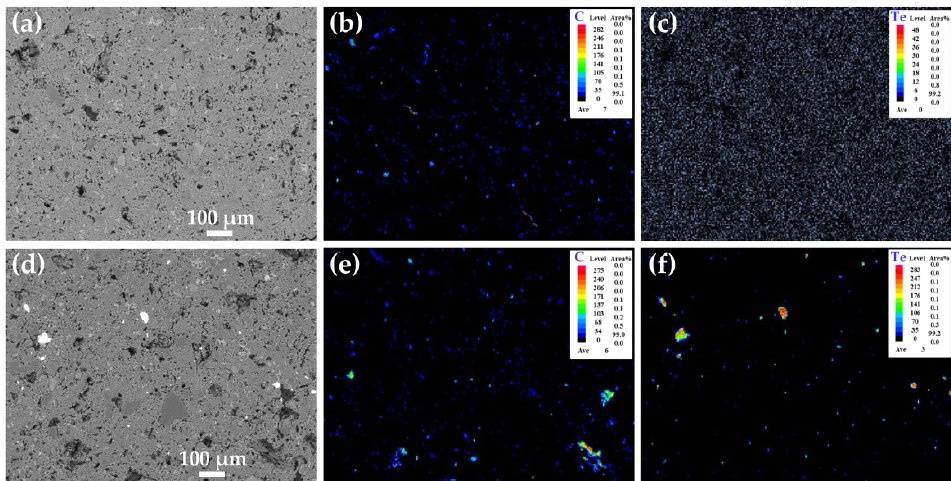
Figure 5. ( a ) BEI of Bi 0.5 Sb 1.5 Te 3 /CNTs cement composites at 0.0 vol.% Bi 0.5 Sb 1.5 Te 3 . The correspond- ing elemental maps are shown in ( b ) C and ( c ) Te; ( d ) BEI of of Bi 0.5 Sb 1.5 Te 3 /CNTs cement composites at 1.0 vol.% Bi 0.5 Sb 1.5 Te 3 . The corresponding elemental maps are shown in ( e ) C and ( f ) Te.